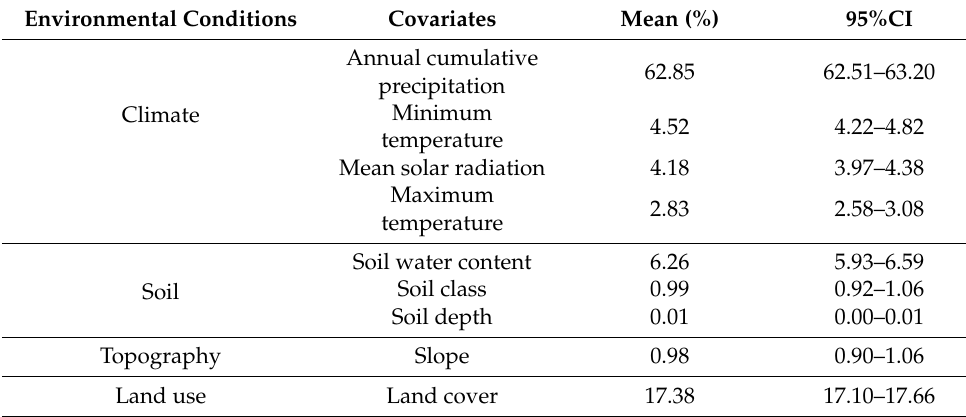
Table 3. Relative contribution of each spatial predictor variables.